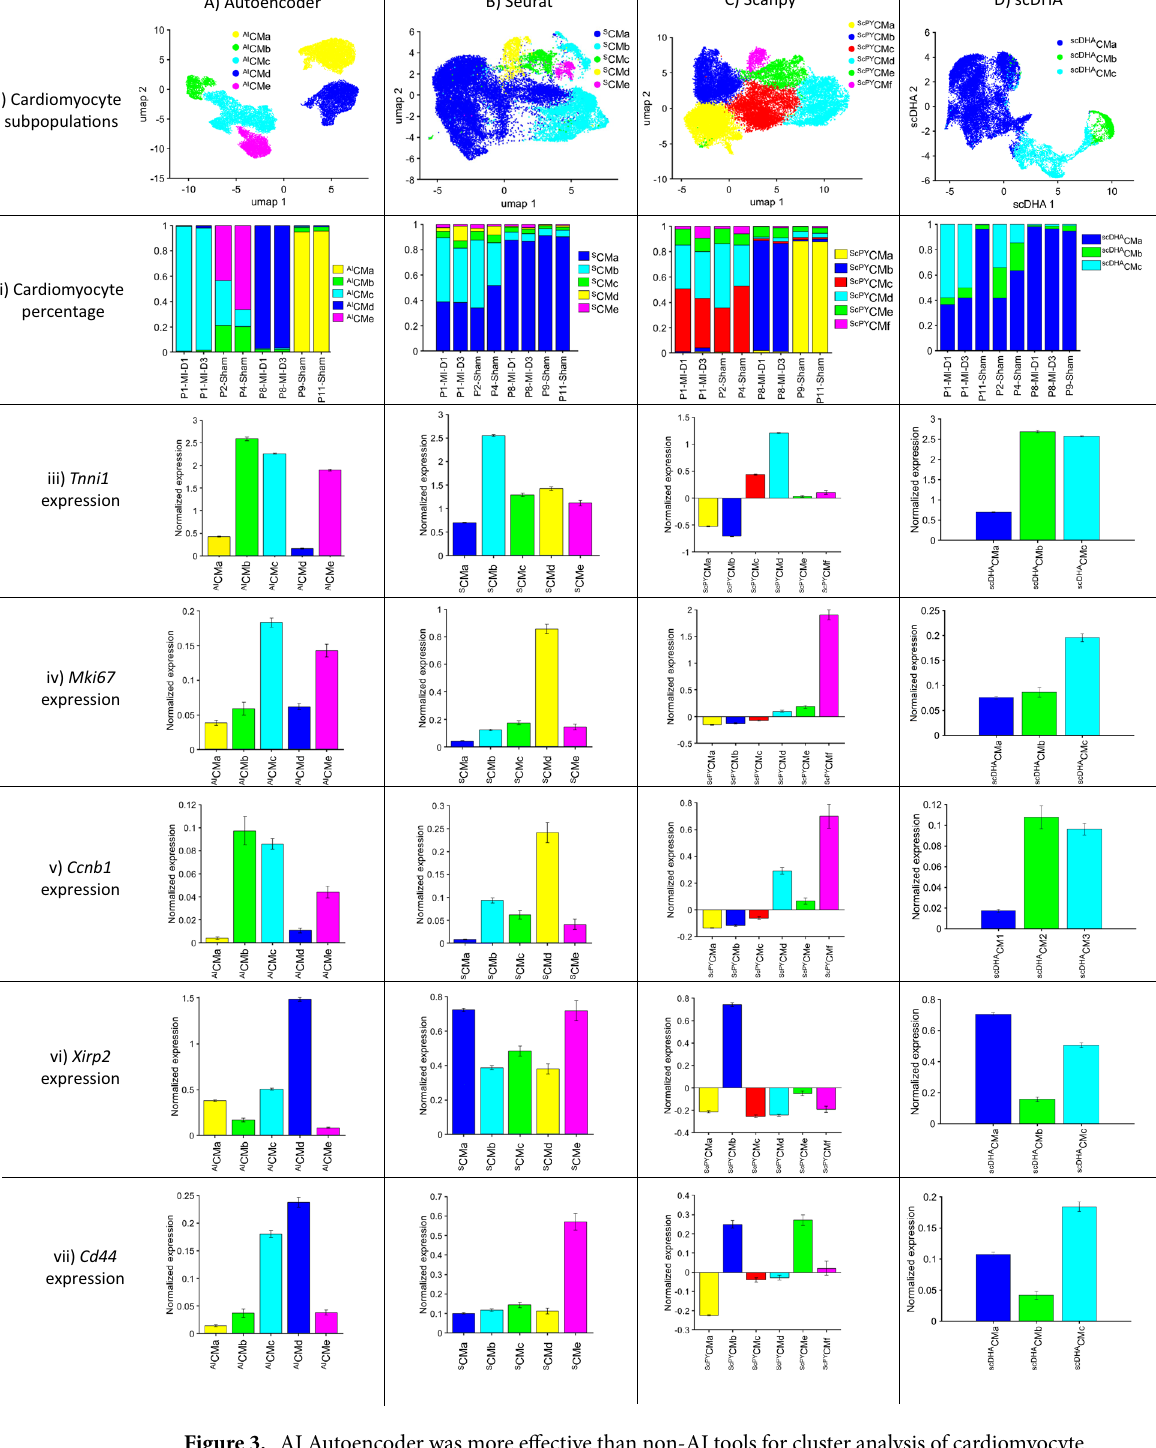
Figure 3. AI Autoencoder was more effective than non-AI tools for cluster analysis of cardiomyocyte scRNAseq data from mouse hearts. Cluster analysis of cardiomyocyte scRNAseq data was conducted via ( A ) AI Autoencoder (clusters AI CMa- AI CMe), ( B ) Seurat (cluster S CMa- S CMe), ( C ) ScanPY (clusters ScPY CMa- ScPY CMf), or ( D ) scDHA (cluster scDHA CMa- scDHA CMc) and displayed via (Row i) UMAP for identification of cardiomyocyte subpopulations. (Row ii) The proportion of cardiomyocytes from each cluster is displayed for each injury group and time point. (Rows iii-vii) The expression of (iii) Tnni1 , (iv) Mki67 , (v) Ccnb1 , (vi) Xirp2 , and (vii) Cd44 was quantified for each cardiomyocyte cluster. Similarities between cluster labels are coincidental (e.g., clusters AI CMa, S CMa, and ScPY CMa do not represent the same subpopulation). Expression data were normalized as in Seurat, briefly: the raw counts were logarithm (base 2) transformed and scaled according to the total of UMIs and detected genes per